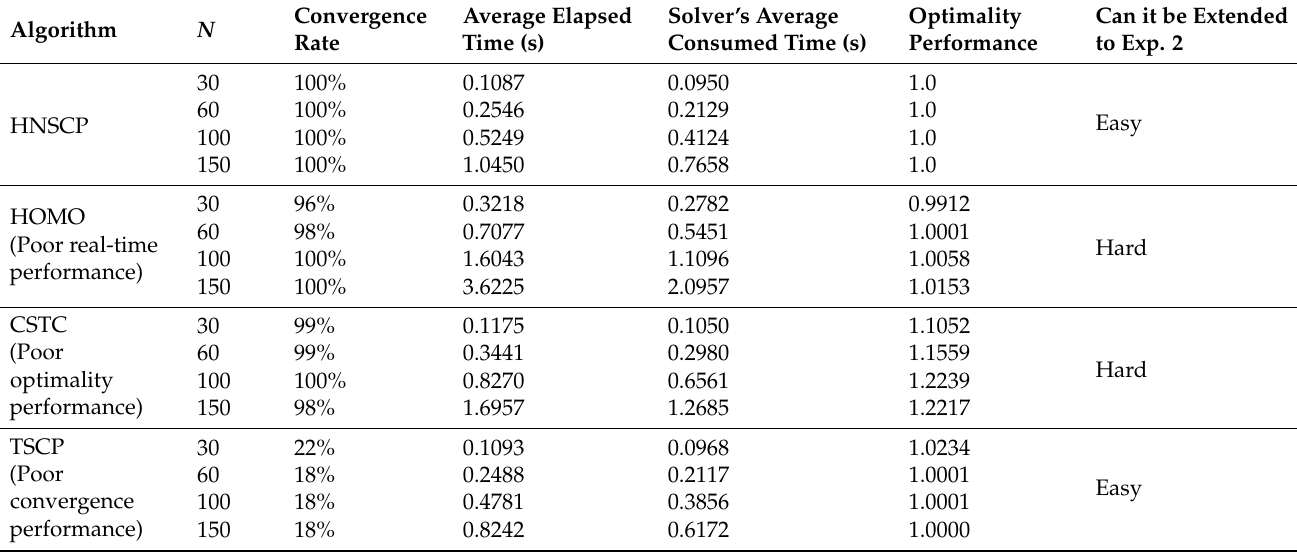
Table 7. Monte Carlo simulation of Example 1.